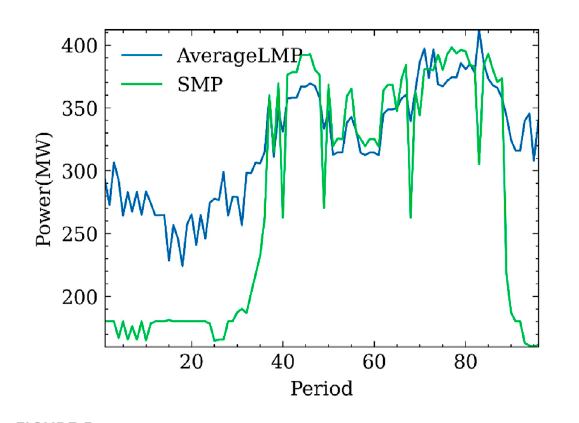
FIGURE 5 Comparison diagram of average LMP and